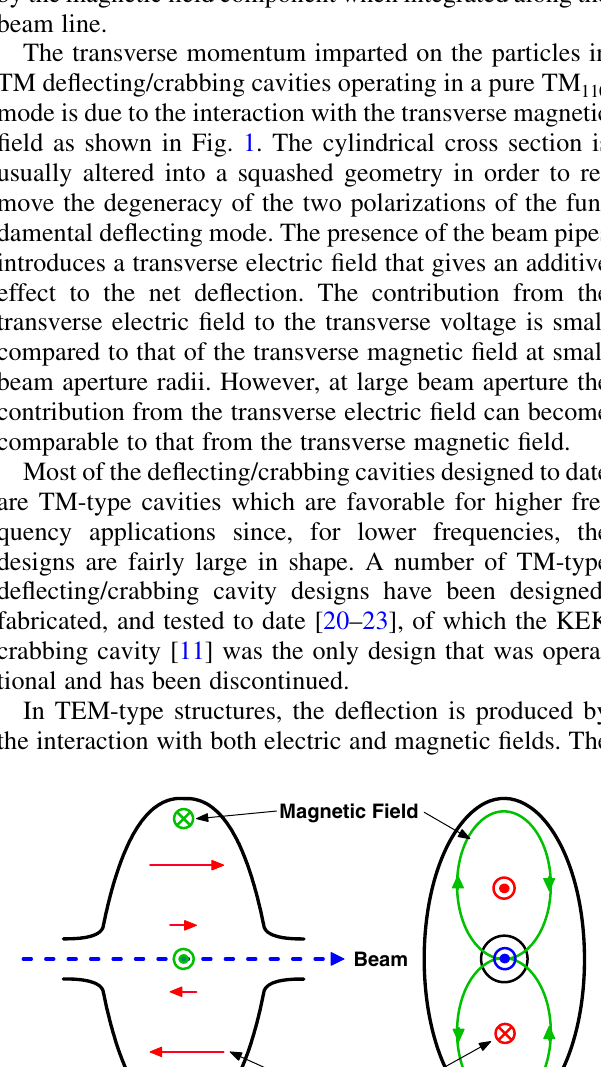
FIG. 2. Field diagram of the deflecting mode in a TEM-type parallel-bar